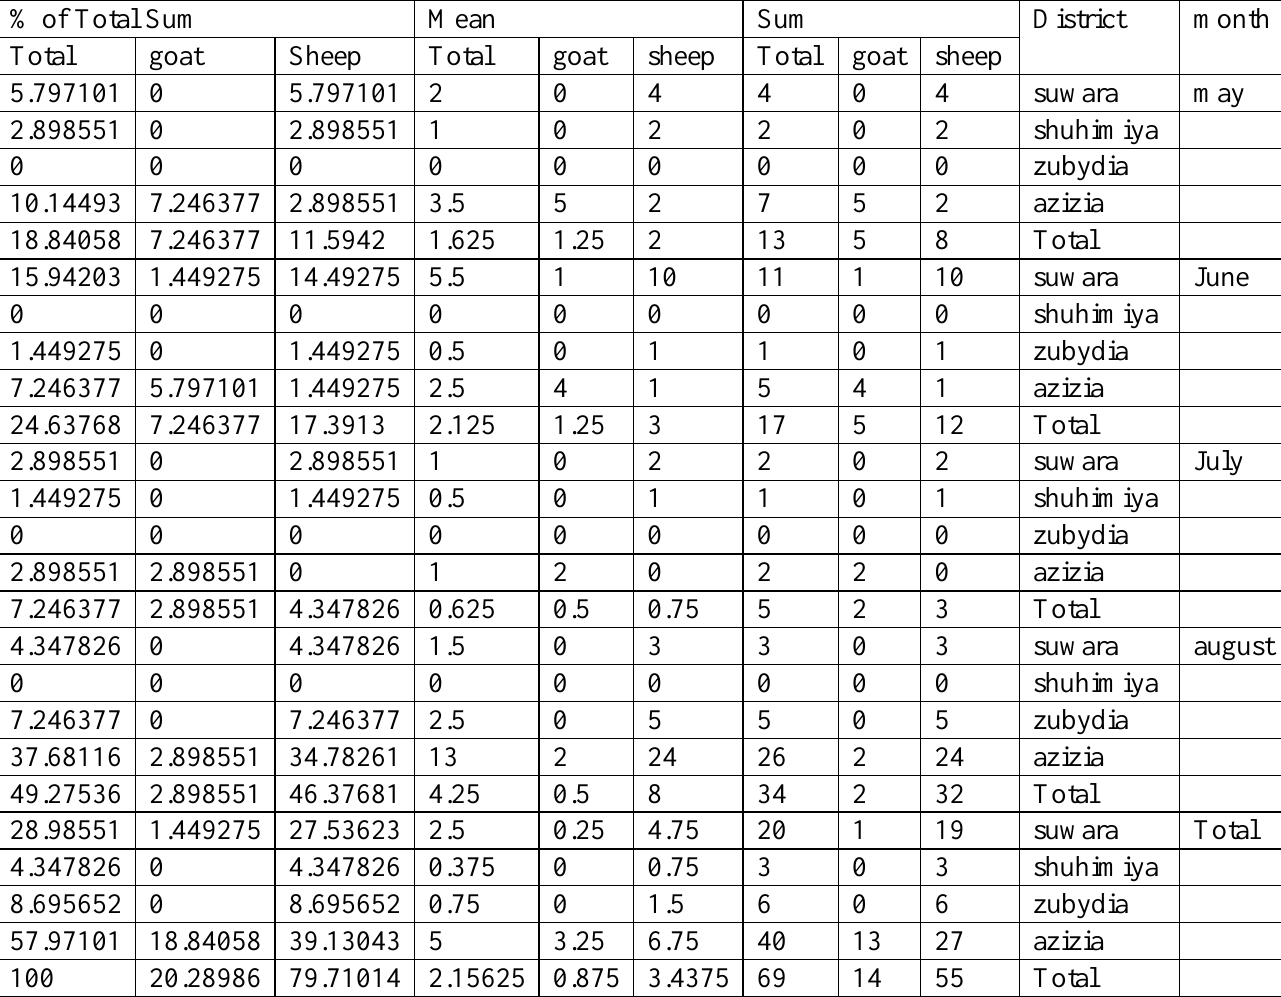
Table (1) : percentage of ticks infestation in sheep and goats in different areas in Wasit from May to August